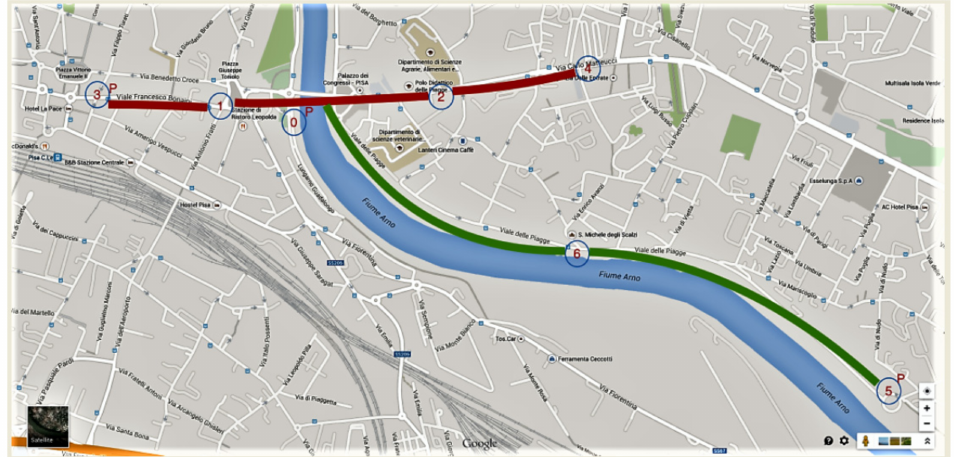
Figure 1. Fixed sensor nodes along the Arno River green park (green route) and along a crowded traffic zone (red route). Five nodes were positioned on the red route (nodes 0, 1, 2, 3, and 4). Node 0 was also on the green route, where two additional nodes were positioned (nodes